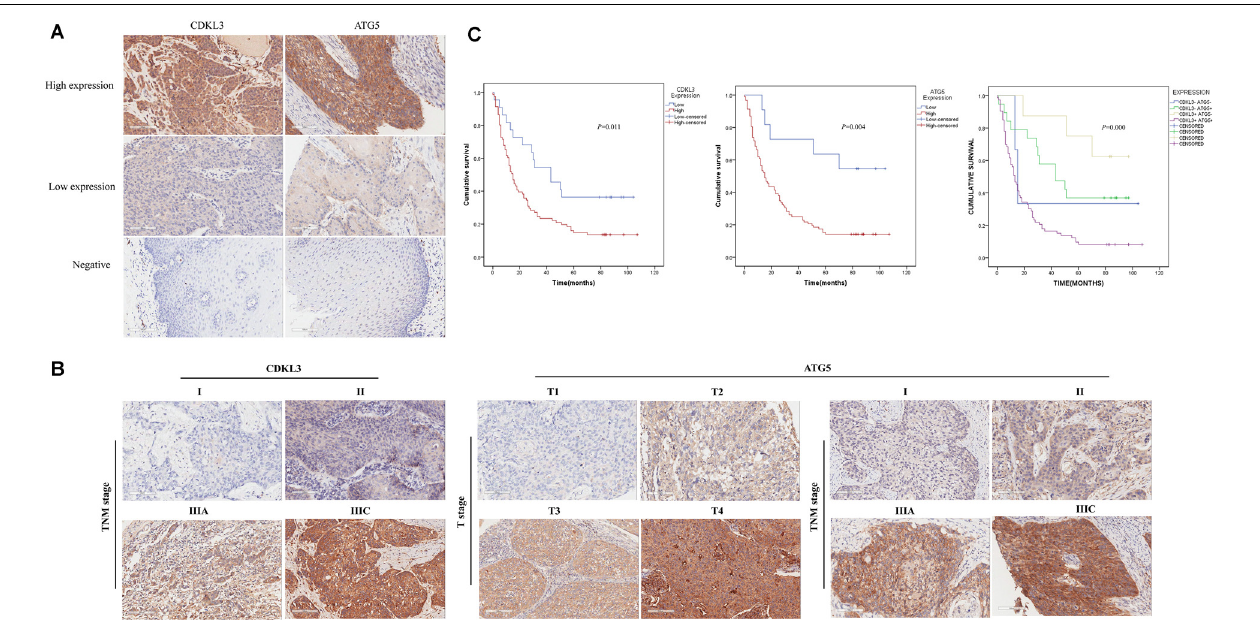
FIGURE 7 | The expression of CDKL3 and ATG5 is upregulated in ESCC tissues and predicts a poor clinical outcome. (A) typical immunohistological pictures with high expressions of CDKL3 and ATG5 in ESCC. The staining showed predominantly cytoplasmic localization, Magnifications 200 × . (B) Representative images of CDKL3 staining according to TNM stage and representative images of ATG5 staining according to the T stage and TNM stage in ESCC patients (magnification, 200 × ). (C) Kaplan–Meier survival curve was drawn to analyze the prognostic significance of CDKL3 and ATG5 expression in overall survival of ESCC patients.